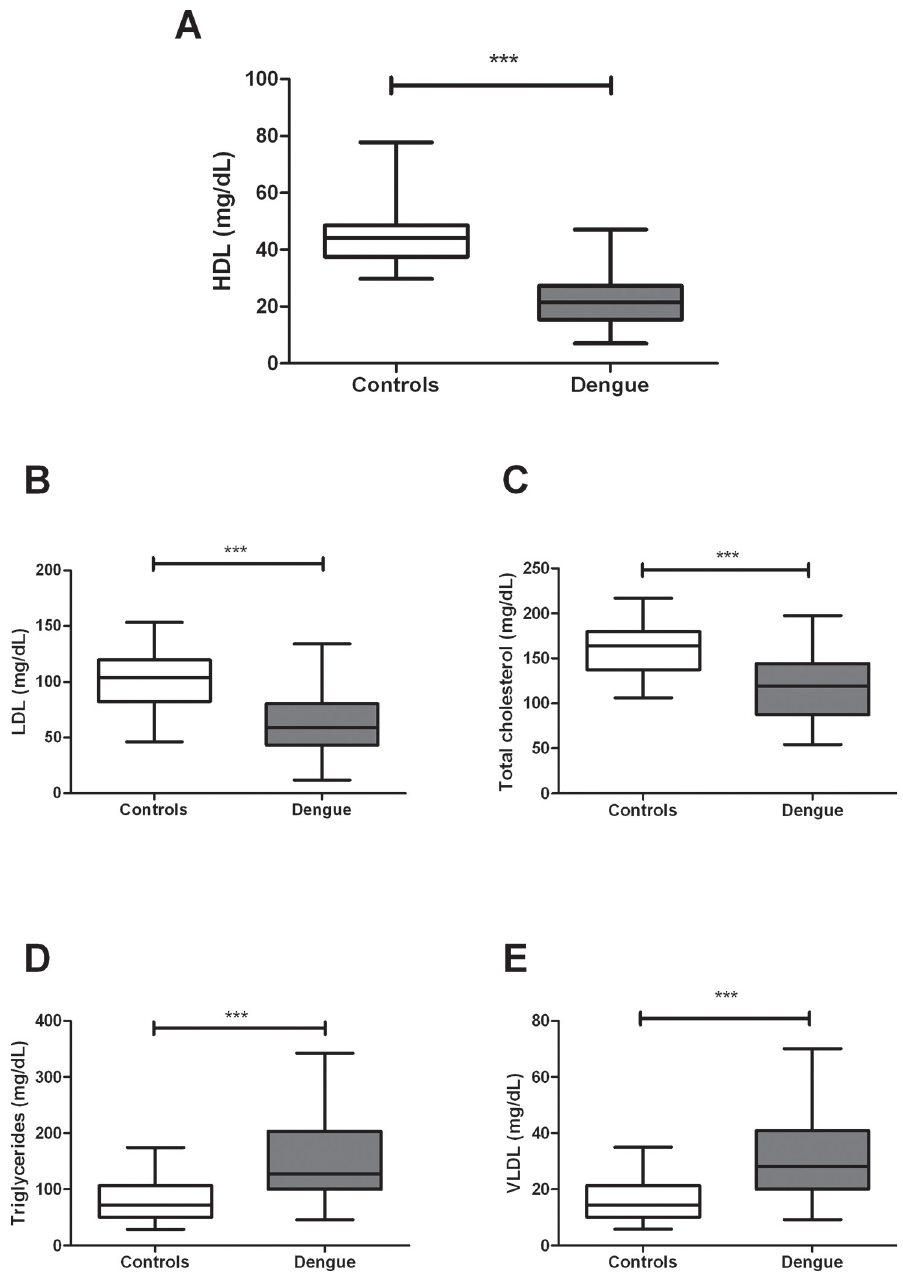
Fig 1. Serum lipid profile in individuals with dengue differs from that of healthy controls. (A) HDL, (B) LDL, (C) Total cholesterol, (D) Triglycerides and (E) VLDL were quantified by duplicated, using a colorimetric assay. The results are presented as medians with maximum and minimum values (box and whisker plot). Statistical comparison was made using the Mann-Whitney U test with a confidence level of 95%. Significant differences are represented at the top of the figure ( ��� p <